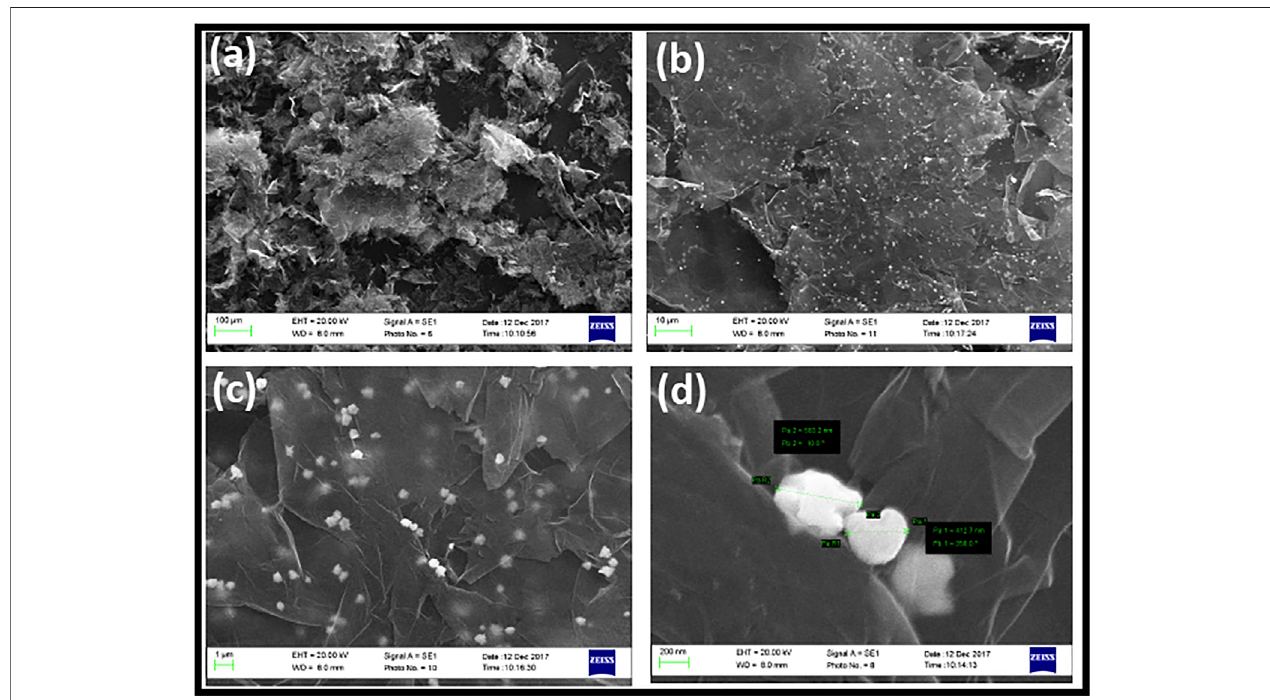
FIGURE 3 | (A – D) Low and high magni fi cation SEM images of the as synthesized graphene-Au composite.